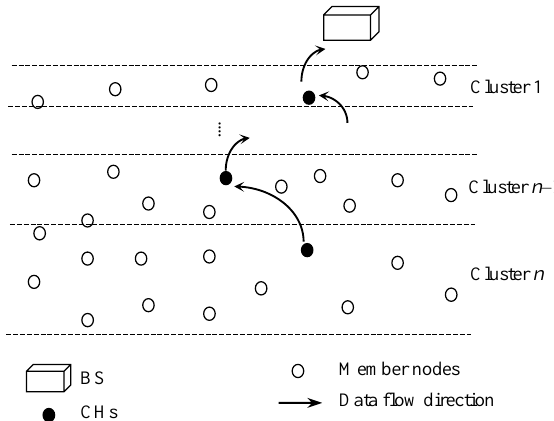
Figure 1. Architecture of a WSN with unequal clustering approach with serial partitioning.